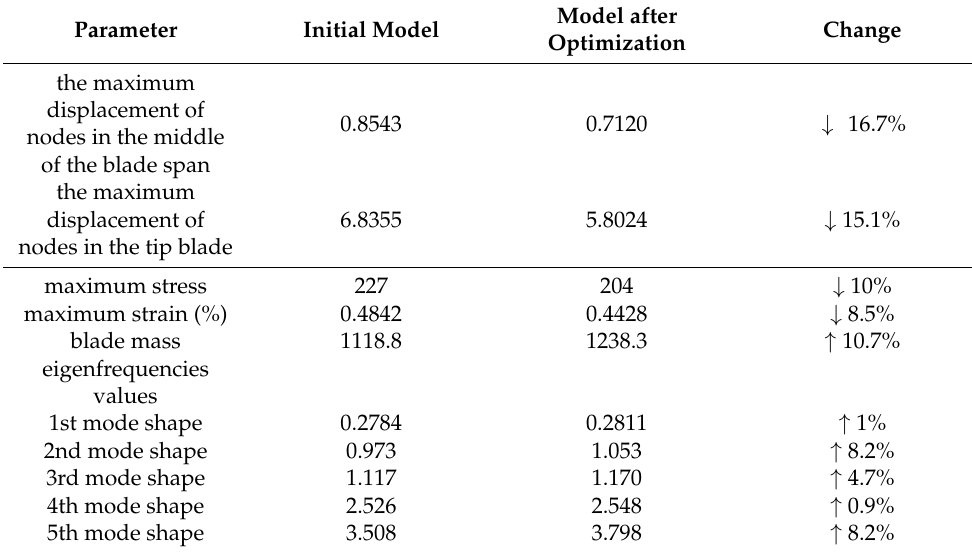
Table 6. The summarized properties of the wind turbine blade (International